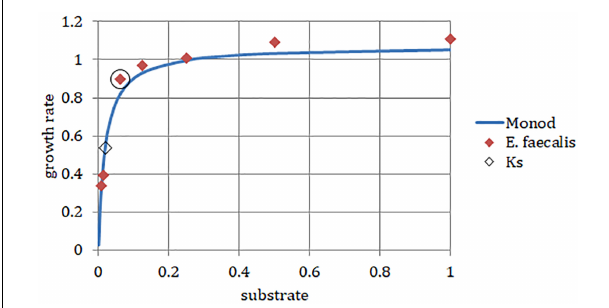
FIGURE 4 | Enterococcus faecalis static cultures. Data points, highest growth rates attained at respective concentrations of TSB (encircled point: concentration used in the laboratory chemostat). Monod, hyperbolic function curve using parameters calculated from data points ( µ max = 1.07 h − 1 ; K s = 0.019). Horizontal axis, concentration of TSB (arbitrary units reflect a fraction of the full concentration from no dilution to 1/128, omitting the dilution 1/32). Vertical axis, growth rate (h − 1 ).